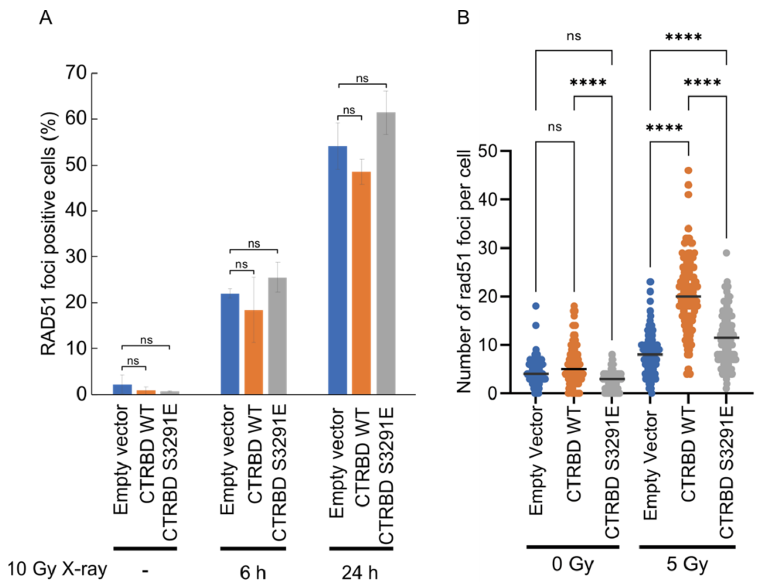
Figure 6. Exogenous expression of the BRCA2 CTRBD increases the number of RAD51 foci. ( A ) Wild-type or S3291E-mutated CTRBD (3260–3331 aa)-expressing cells were irradiated with X-ray at a dose of 10 Gy. These cells were harvested after 6 and 24 h. Cells with more than five RAD51 foci were considered RAD51 focus-positive cells. Results are presented as the mean, and error bars indicate the standard deviation ( n = 3). Significance was examined using an F-test, followed by Student’s t -test with Holm’s correction. Results are indicated as the mean at each X-ray or MMC dose, and error bars indicate the standard deviation ( n = 3). ns; non-significant. ( B ) Wild-type or S3291E-mutated CTRBD (3260–3331 aa)-expressing cells were irradiated with X-ray at a dose of 5 Gy and harvested after 4 h. The RAD51 foci per cell were counted and are presented as a dot plot. The lines indicate the median. Significance was examined using Student’s t -test with Holm’s correction or Tukey’s HSD multiple comparison test. Asterisks indicate significant differences (**** p < 0.0001).